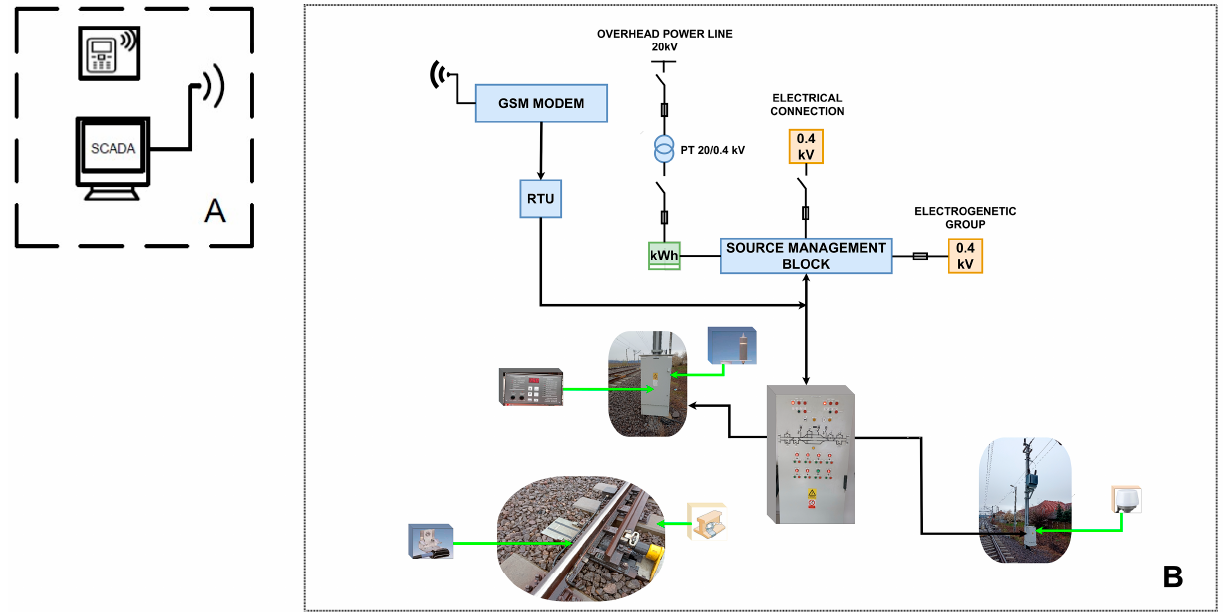
Figure 10. Setup of the control system applied in the field. RTU = remote terminal unit.